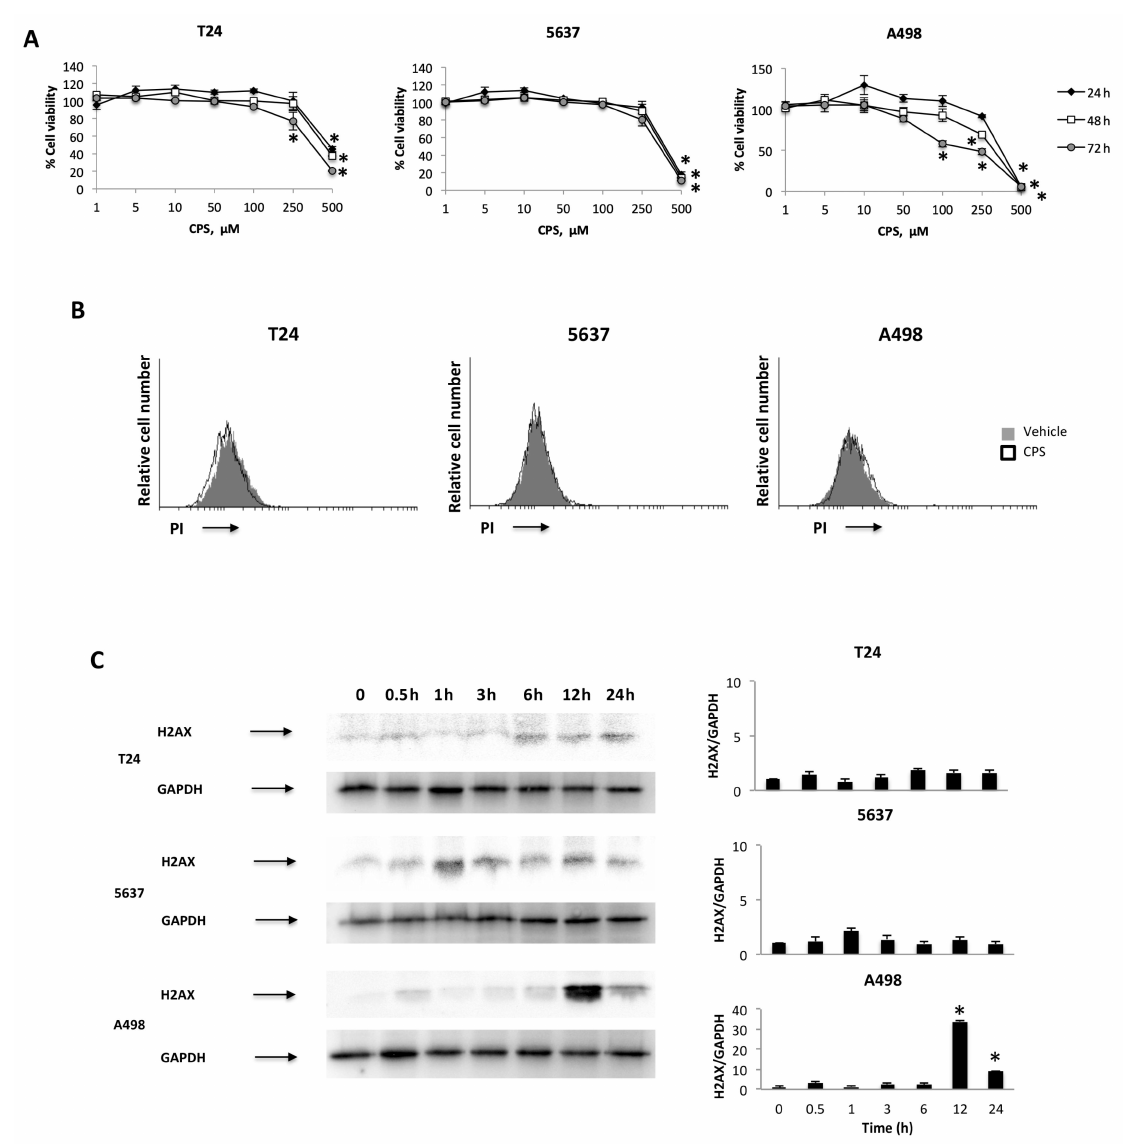
Figure 1. CPS effects on T24, 5637 and A498 cell lines. ( A ) Cell viability was evaluated by 3-(4,5- dimethylthiazol-2-yl)-2,5-diphenyltetrazolium bromide (MTT) assay in T24, 5637 and A498 cells treated with different doses of CPS for up to 72 h. Data shown are expressed as mean ± SE of three separate experiments; * p < 0.05. ( B ) T24, 5637 and A498 cells were treated with 50 µ M CPS for 24 h and then PI incorporation was analyzed by flow cytometry. Histograms are representative of one of three separate experiments. ( C ) Representative immunoblots for H2AX expression levels in total cellular lysates from T24, 5637 and A498 cells treated with CPS for up to 24 h. Blots are representative of one of three separate experiments. H2AX densitometry values were normalized to GAPDH, used as the loading control. The H2AX protein levels were determined with respect to time 0. Data are expressed as mean ± SD; * p < 0.001. Detailed information about the Western blotting can be found in Figure